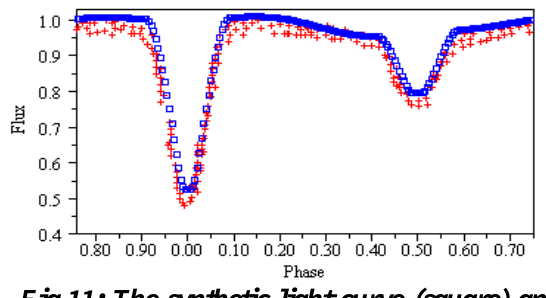
Fig.11: The synthetic light curve (square) and the experimental light curve (+) of unspotted Model of Eclipsing binary RT And.